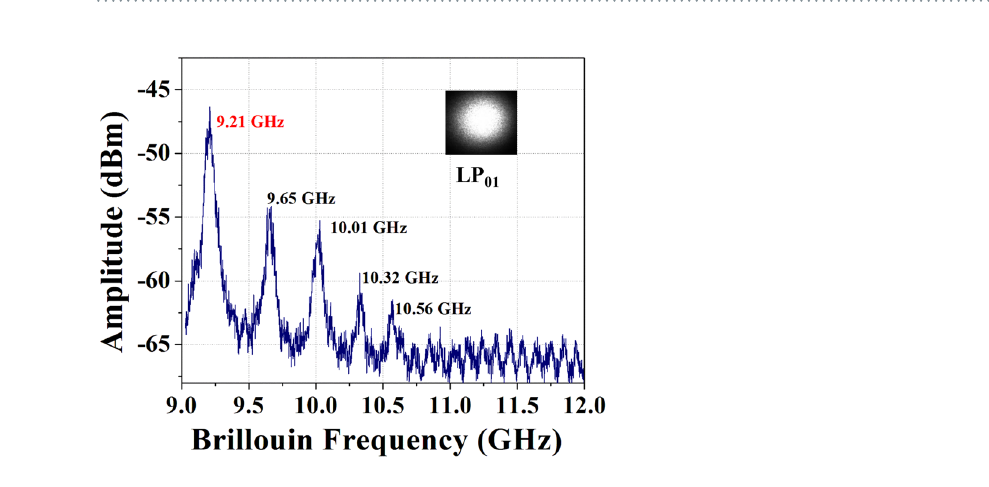
Figure 3. Full Brillouin gain spectra of the fundamental LP 01 mode of FMF at 1550